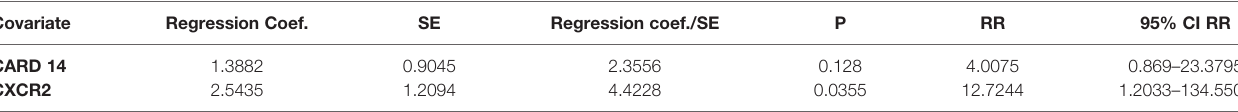
TABLE 5 | Multivariate analysis of gene expression for the diffuse subset. Covariate Regression